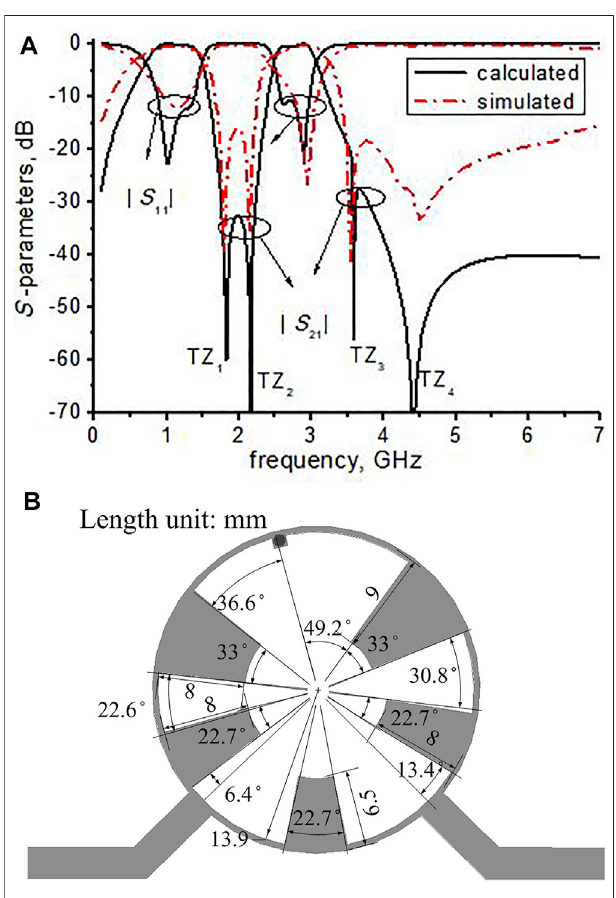
FIGURE 4 | Calculated and measured S-parameters and optimized structure (A) calculated and simulated S-parameters (B) optimized BPF structure.